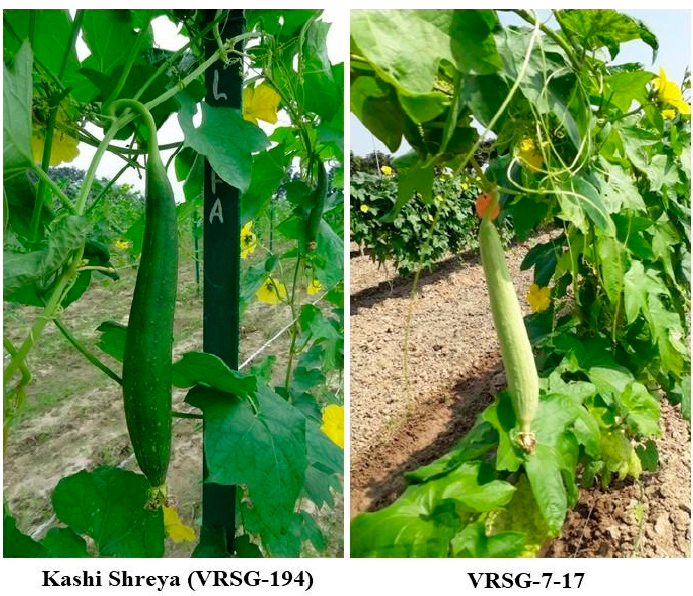
Figure 1. Morphological features of different parental lines of sponge gourd. Table 1. Observed segregation ratio and the Chi-square ( χ 2 ) value for the goodness-of-fit to mono- genic model for F 2 and test cross population derived from a cross between aromatic and non-aromatic Luffa